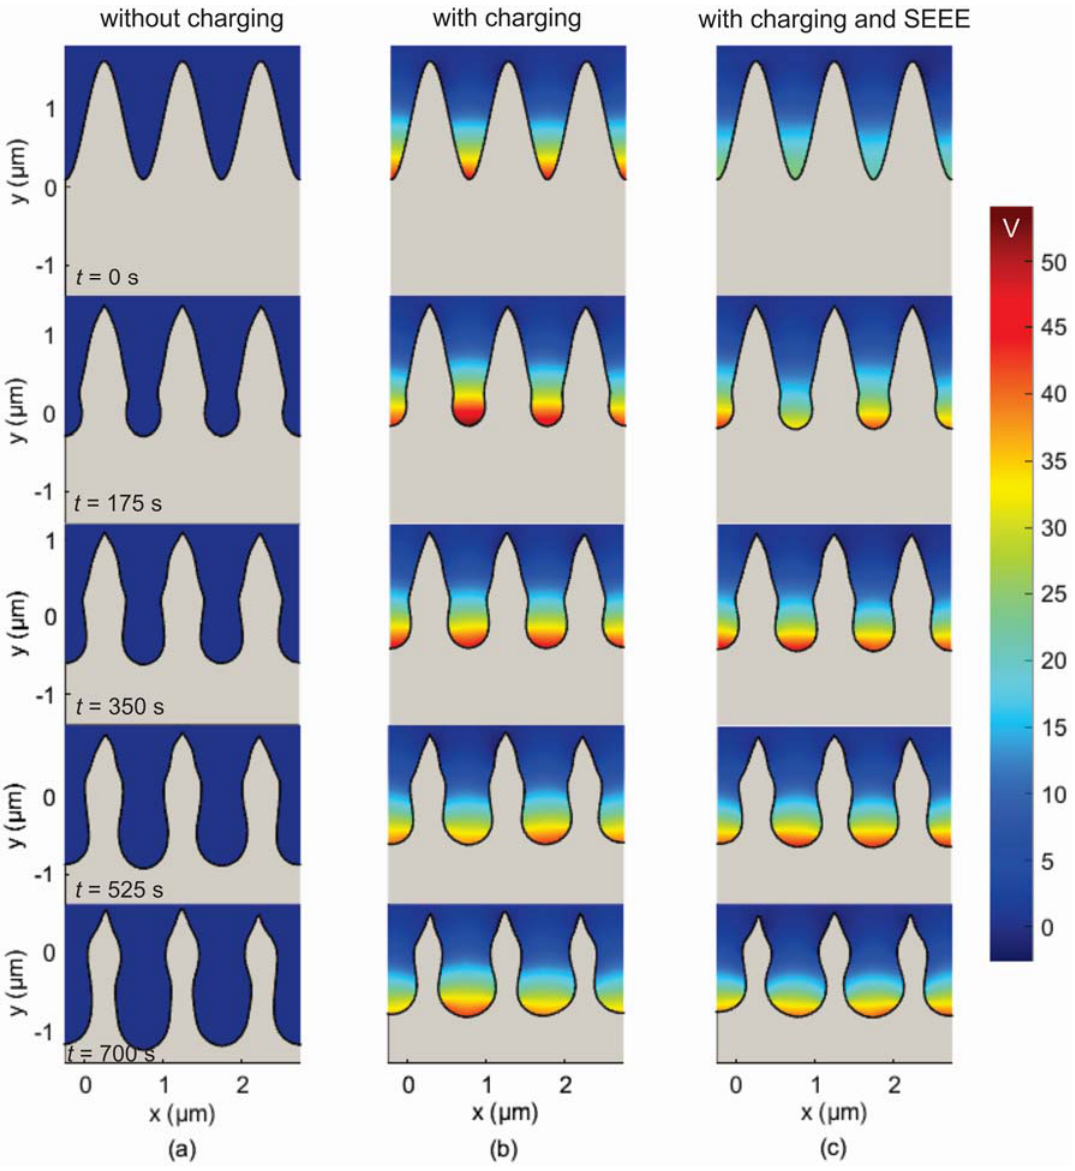
Figure 6. Snapshots of the surface profile for different etching times ( a ) without charging (multimedia view, please see Figure6a.avi), ( b ) with charging (multimedia view, please see Figure6b.avi), and ( c ) with charging and SEEE (multimedia view, please see Figure6c.avi), when the ion reflection is taken into account. The profiles are cut from the middle of the first valley to the middle of the last one. The charging potential for snapshots of Figure 6b,c is also depicted.